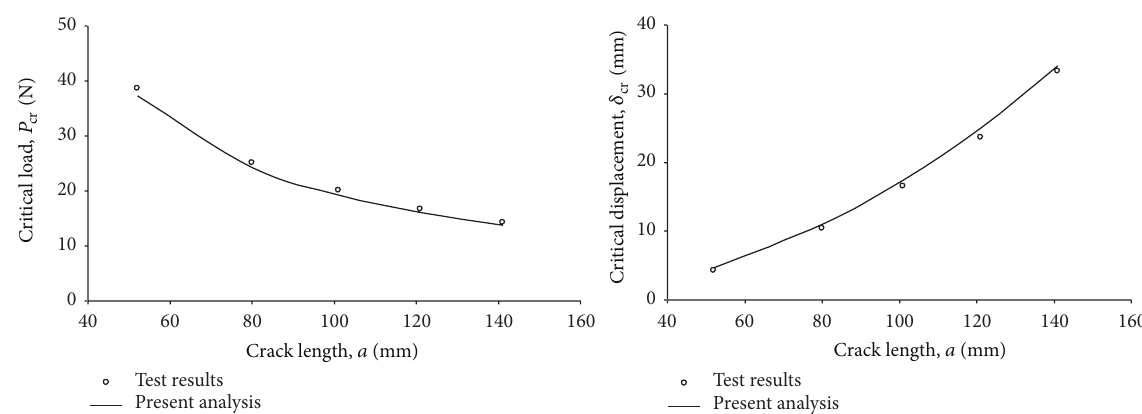
) and the corresponding displacement (𝛿 ) cr cr